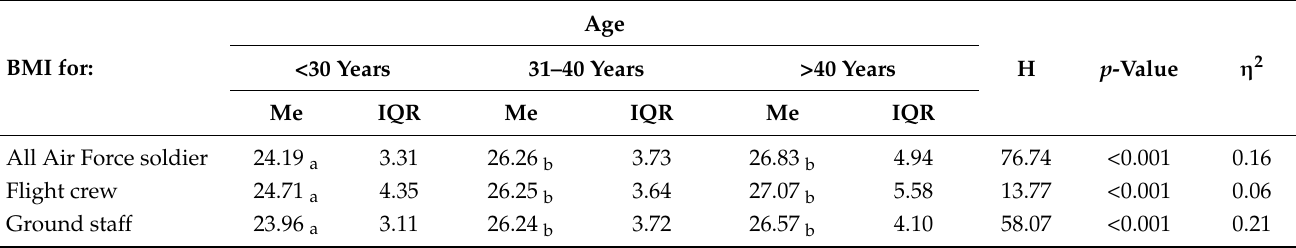
Table 2. Summary of the BMI of the subjects [kg/m 2